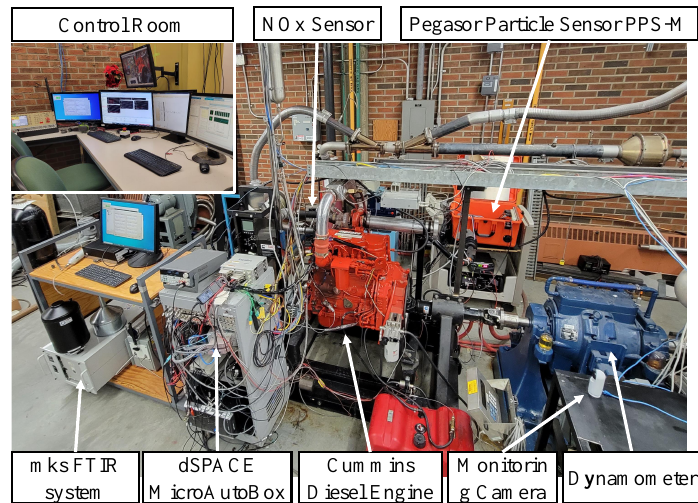
Figure 5. Experimental setup of the diesel engine in this